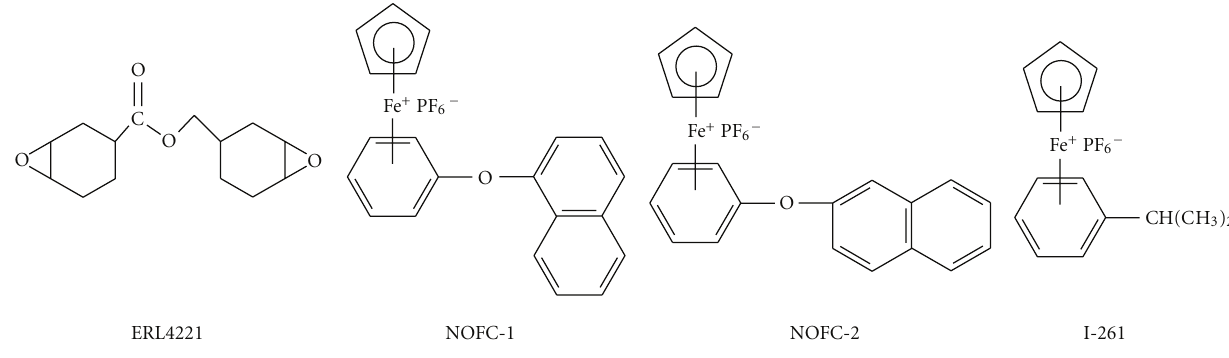
Scheme 1: Abbreviations and structures of epoxy compounds and photoinitiators